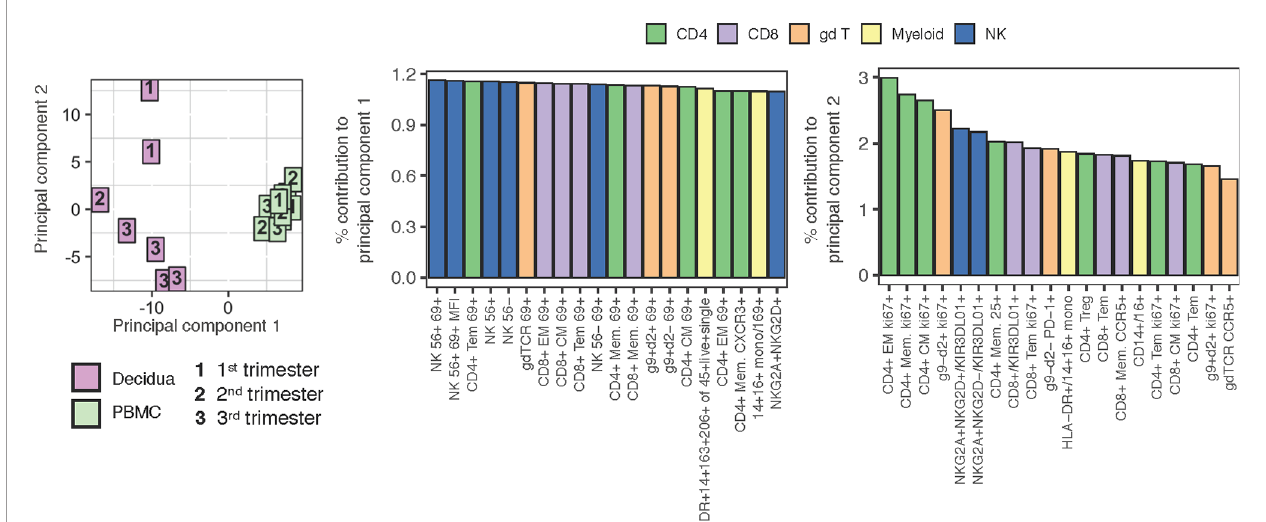
FIGURE 10 | PCA plot using adaptive and innate cell data of PBMC and decidual leukocytes in normal rhesus macaques. A PCA plot was generated using a combination of adaptive and innate immune cells and their features. 217 variables describing frequencies of unique cell types and MFI when applicable (e.g. Granzyme B MFI) were used to contrast PBMC (n = 9) (green) to decidua (n = 7) (pink) samples across 1st, 2nd, and 3rd trimester (left). The top 20 contributing variables to principal component 1 (middle) and principal component 2 (right) are shown and color coded according to major cell populations, CD4+ T (green), CD8+ T (purple), gd T (orange), myeloid CD20-HLA-DR+ (yellow), and NK cells